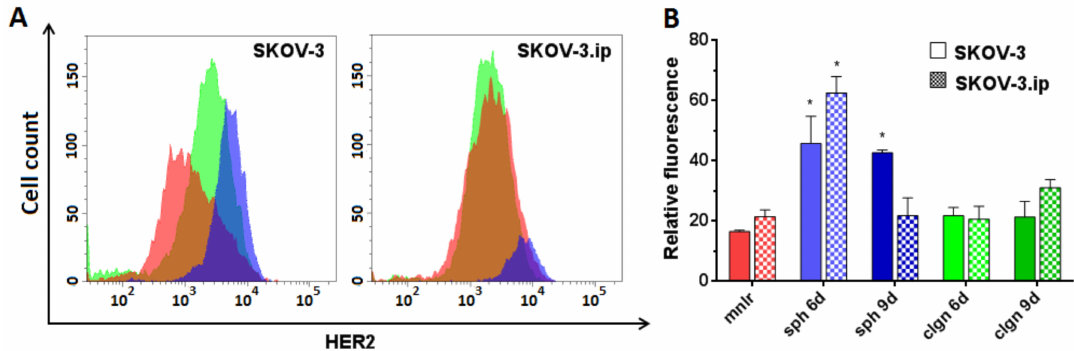
Figure 5. Human Epidermal growth factor Receptor 2 (HER2) expression level in SKOV-3 and SKOV-3.ip cells cultured in monolayer and 3D in vitro models. ( A ) The distributions of SKOV-3 cells (left plot) and SKOV-3.ip cells (right plot) according to fluorescence intensity detected after staining with HER2-specific antibodies (red—monolayer culture, blue—spheroids, green—collagen hydrogel); ( B ) HER2 expression level in monolayer and 3D models denoted as relative fluorescence values. mnlr , monolayer; sph , spheroids; clgn , collagen hydrogel. “*” indicates significant di ff erence in RF level from monolayer culture (ANOVA, Holm–Sidak’s multiple comparisons test, p <